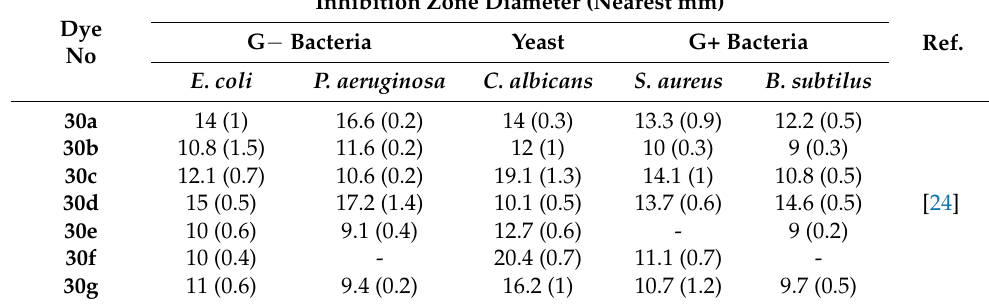
Table 8. Inhibition zones of dyes 30a – h